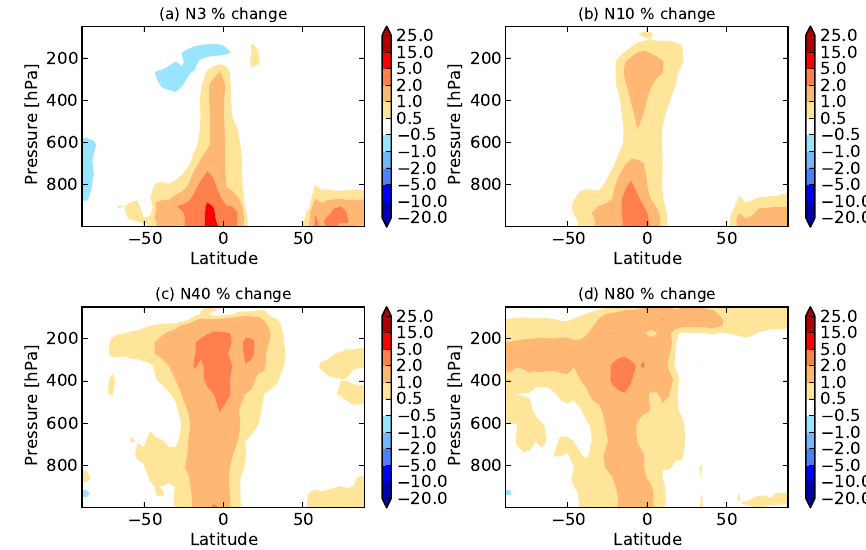
Fig. 7. The annual- and zonal-mean change in N 3, 10, 40 and 80 due to the addition of CI+SO 2 chemistry